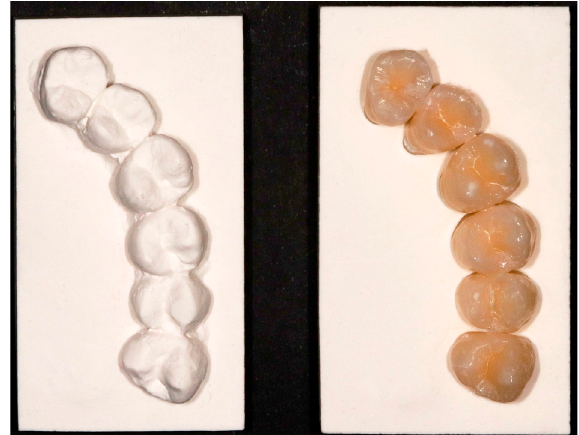
Figure 1. Dental cast